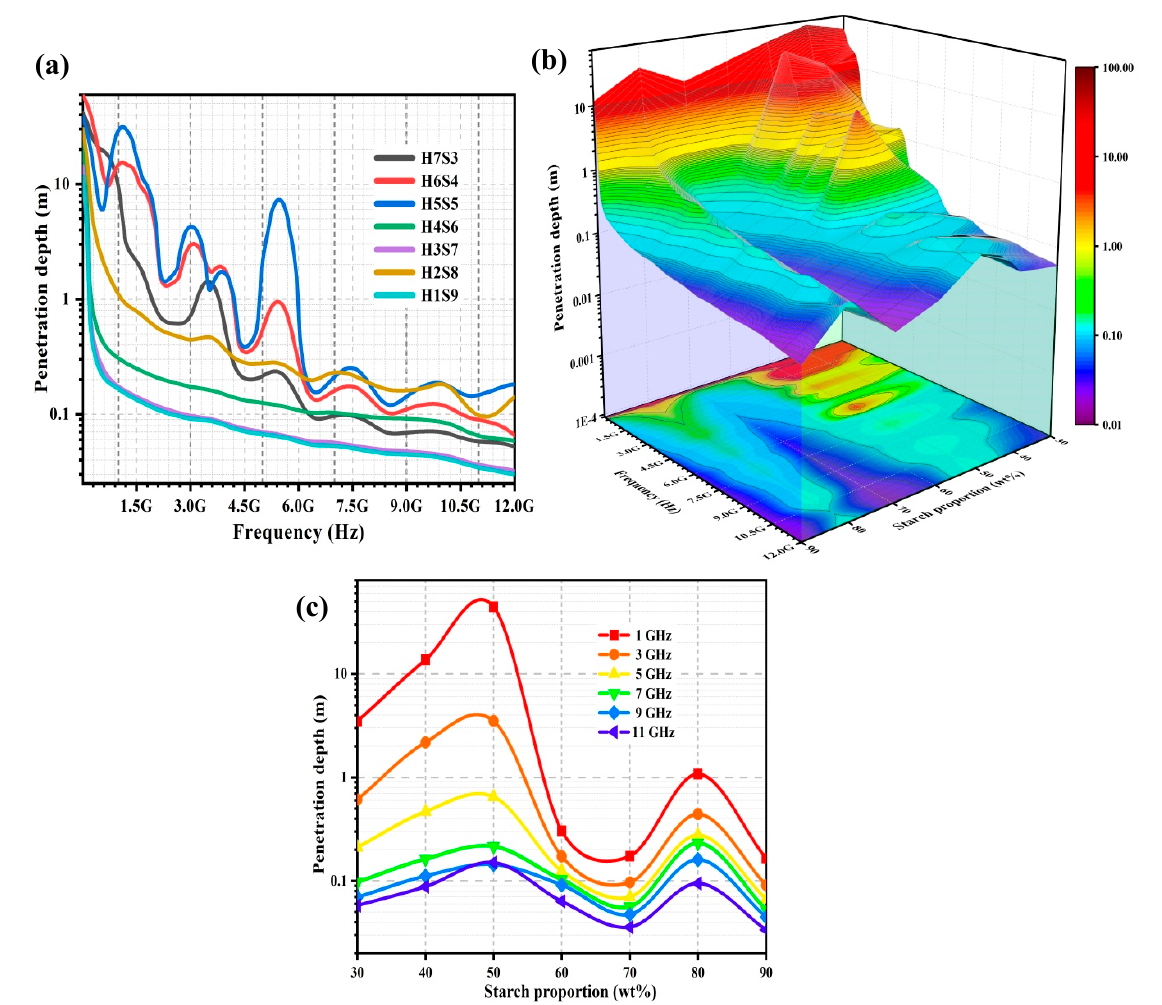
Figure 7. D p spectra ( a ) of the porous nHA/S composites. Three-dimensional representation of D p values of the porous nHA/S composites ( b ). D p curves of the porous nHA/S composites at varied selected frequencies ( c ).